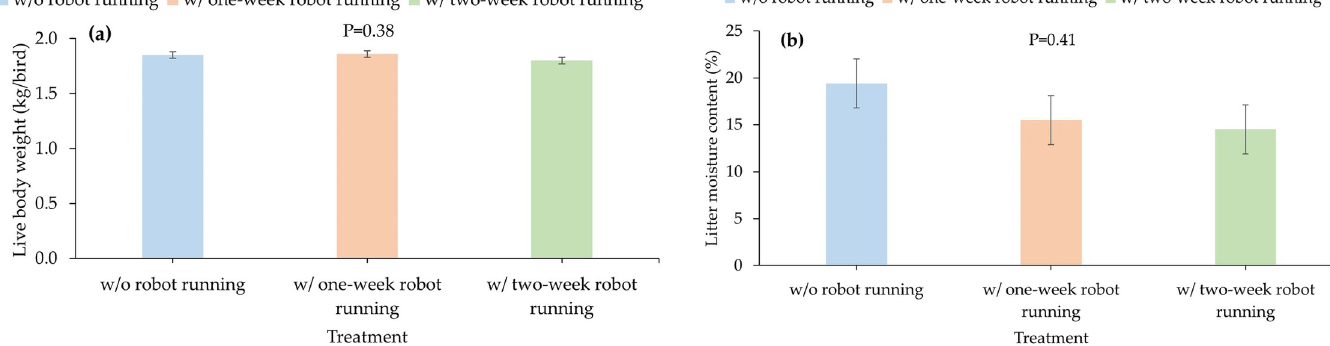
Fig 4. Live body weight (a) (n = 4) and litter moisture content (b) (n = 6) under the treatments. Data were only measured at the end of the experiments (43 weeks of bird age). ‘w/’ and ‘w/o’ represent with and without, respectively.